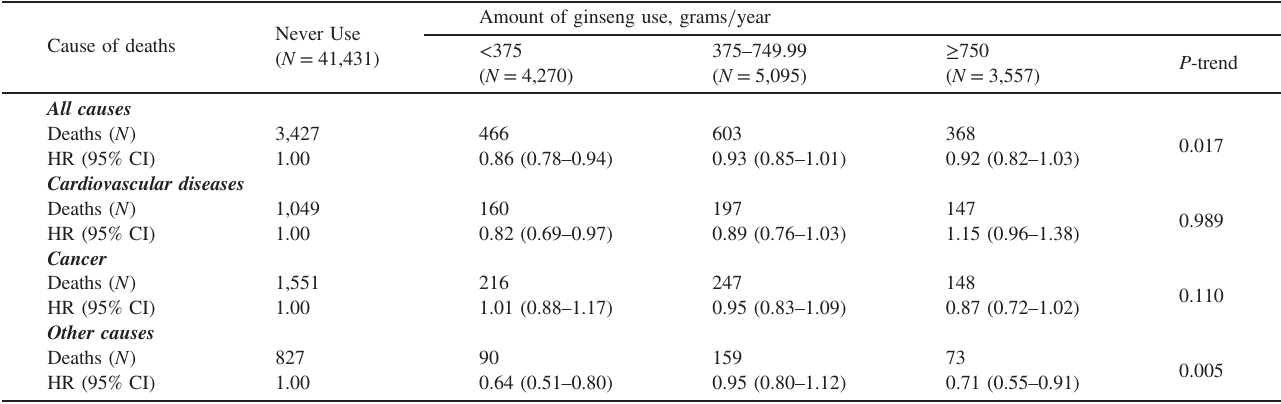
Table 4. HRs a and 95% CIs of mortality associated with amount of consuming either American or White ginseng among individuals who consumed ginseng for perceived general bene fi t for enhancement of health, Shanghai Women ’ s Health Study